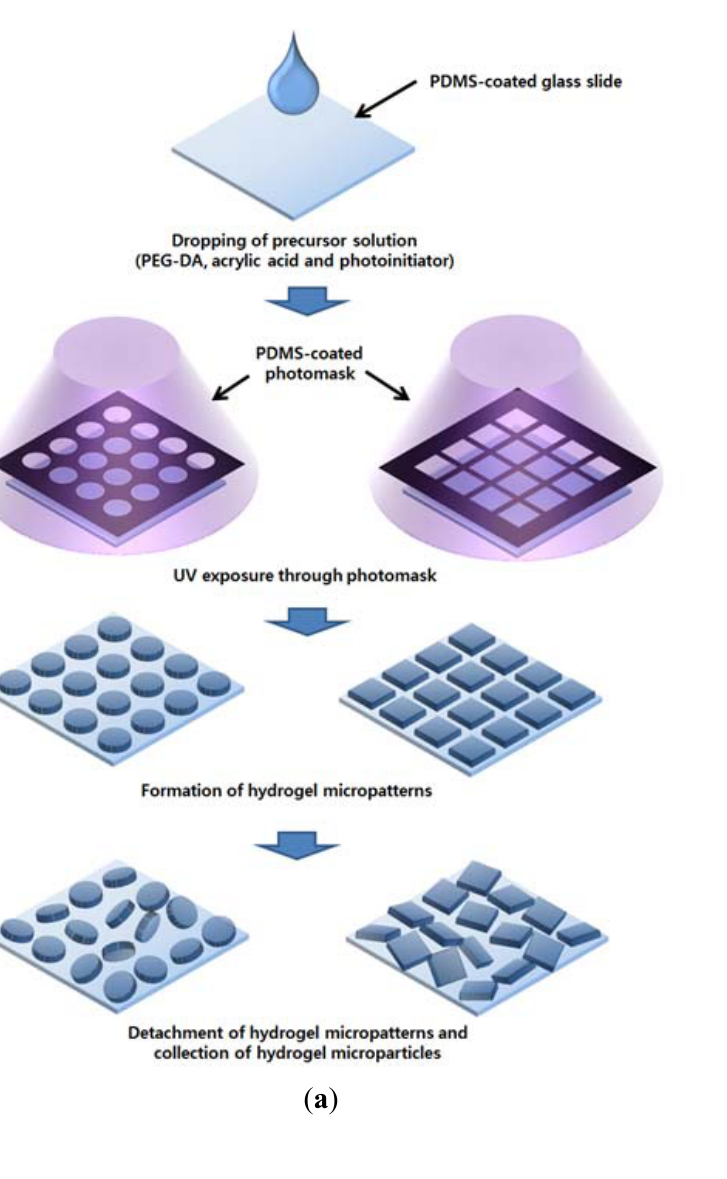
Figure 1. Fabrication of hydrogel microparticles using photopatterning. ( a ) Schematic illustration of preparing hydrogel microparticles. ( b ) Optical images of resultant hydrogel microparticles with different shapes (scale bar: 200 μ